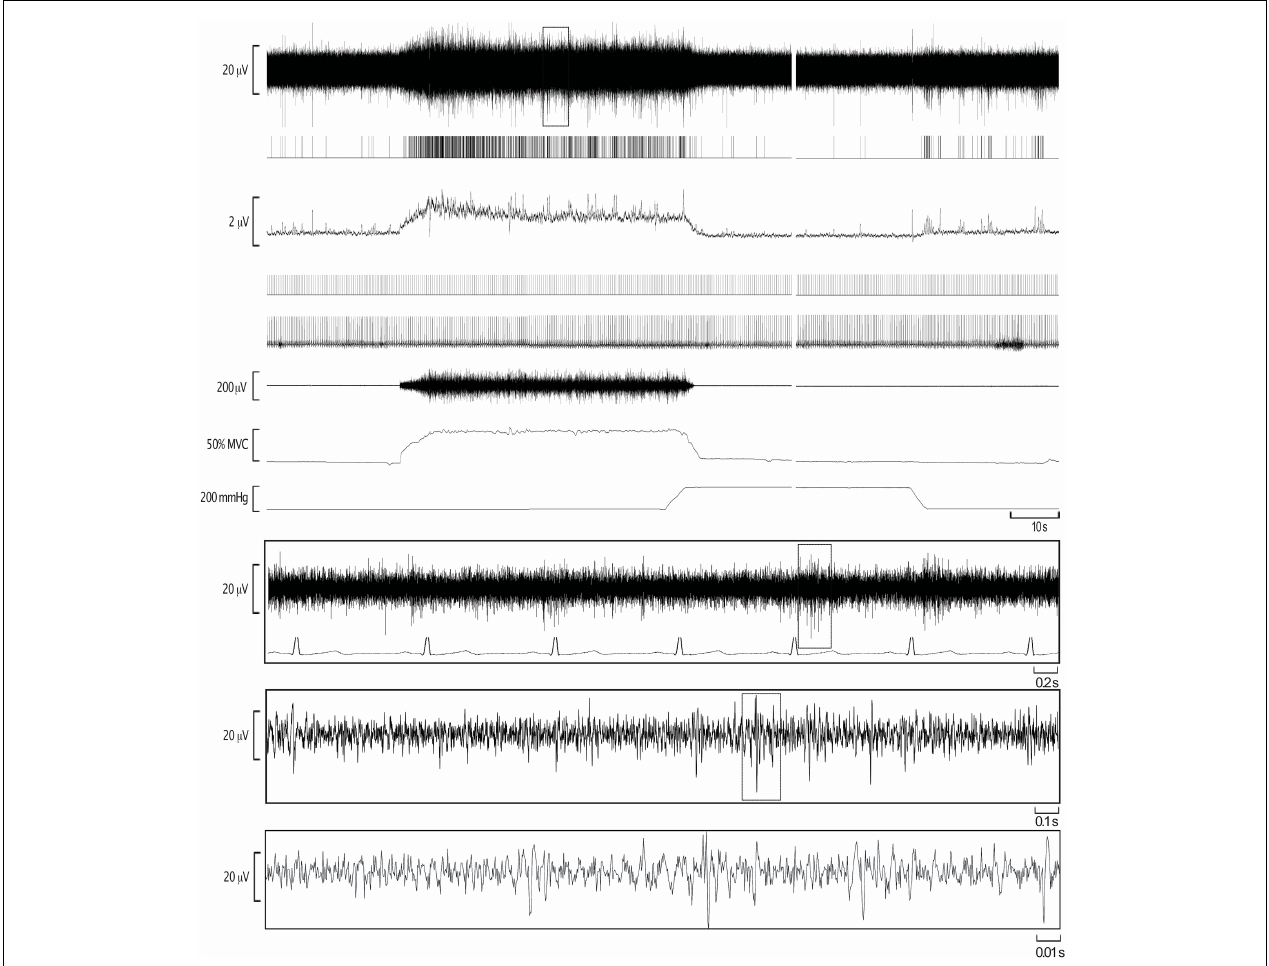
FIGURE 1 | Experimental records from one participant during isometric dorsiflexion of the ankle at 50% of maximal voluntary contraction (MVC), followed by post-exercise ischemia (PEI) and rest. The extracted negative-going sympathetic spikes are shown as standard pulses (MSNA), together with standard pulses indicating the R-waves of the ECG. These event markers were used to construct the autocorrelation histogram for the ECG and the cross-correlation histogram between MSNA and